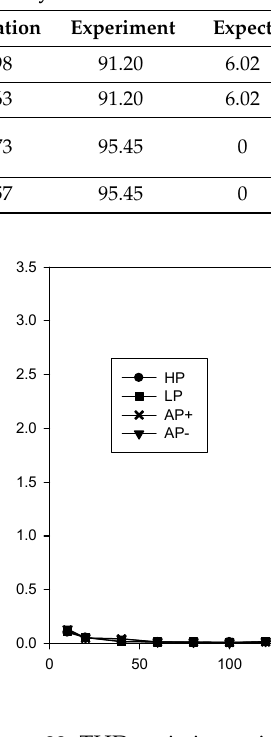
Figure 22. THD variations with input voltage signal at 90 kHz.